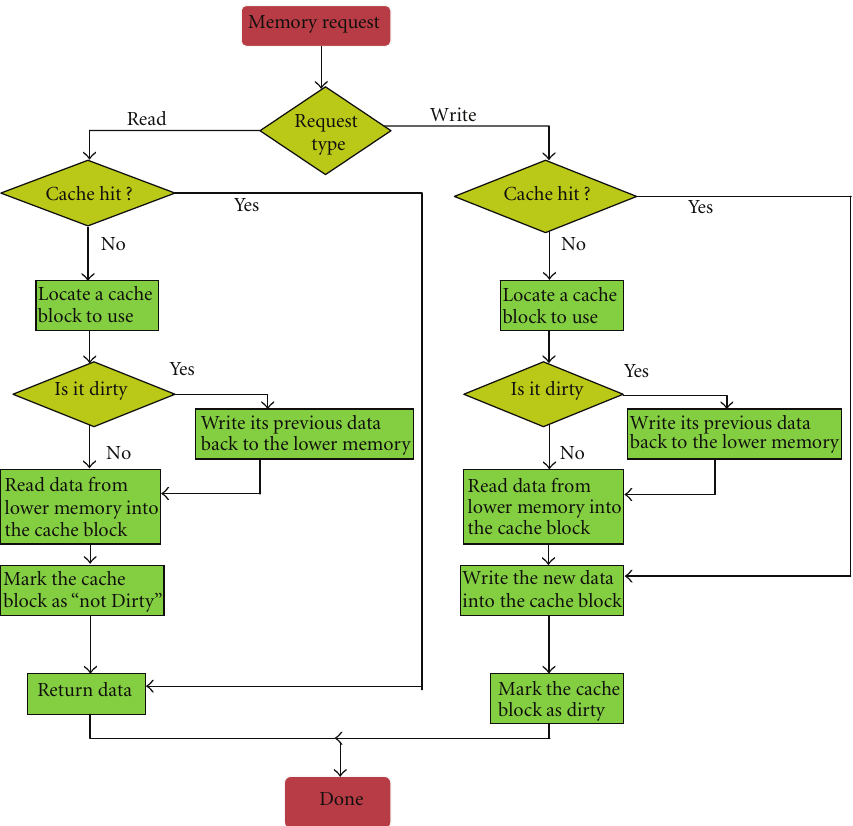
Figure 6: Flowchart showing operations in memory map.